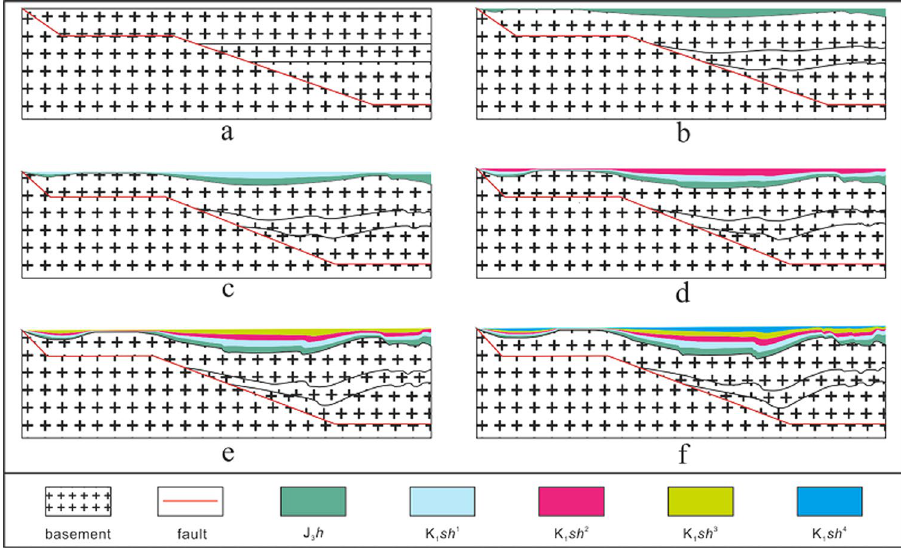
Figure 3. The result of the 2-D simulation showing the dynamic processes corresponding to the formation of the bends on both limbs of the anticline with a ramp/flat basement shape.